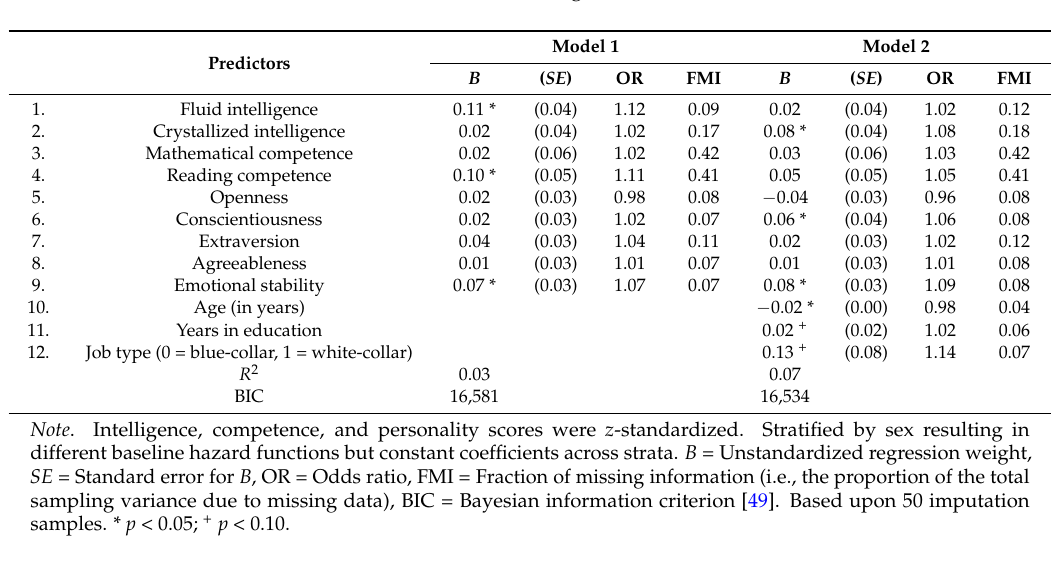
Table 3. Omnibus Cox regression models.